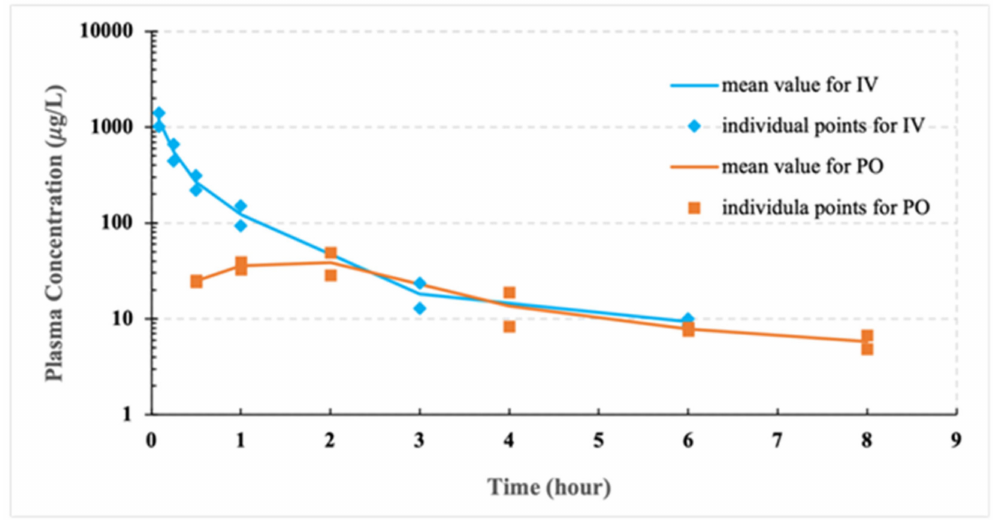
Figure 4. Plasma concentration–time curve for pilot study of CCG-211790 powder suspension ( n = 2) and a DMSO/saline solution ( n = 2) either following oral administration or intravenous administration in Sprague–Dawley rats at a dose of 5 mg/kg or 2.5 mg/kg,